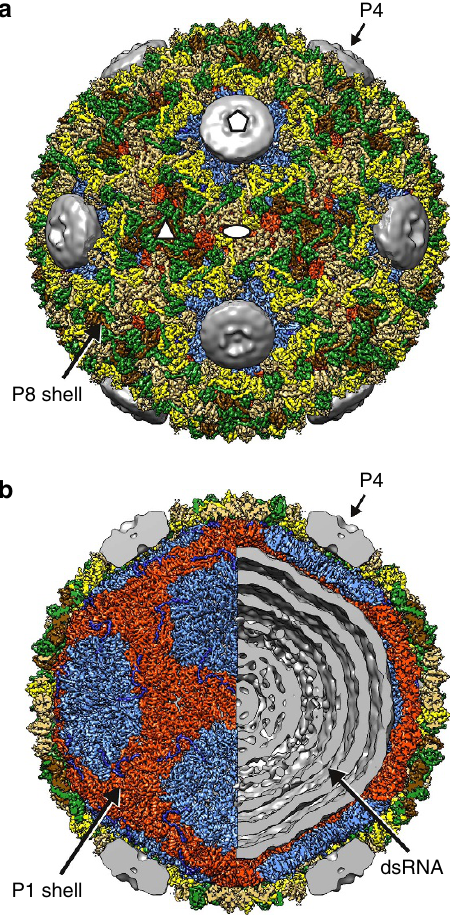
Figure 1 | Cryo-EM structure of bacteriophage / 6 nucleocapsid. ( a , b ) Three-dimensional reconstruction of the NC at 4.0-Å resolution. The P8 trimers forming the outer protein shell are coloured in yellow (P8 Q ), green (P8 R ), gold (P8 S ) and brown (P8 T ). Half of the P8 density was removed to reveal in b the inner protein shell composed of P1 A –P1 B asymmetric dimers, coloured in light blue (P1 A ) and red (P1 B ). The elongated density corresponding to the P4 C-terminus is shown in dark blue. Residual density, not assigned to the aforementioned icosahedrally ordered components was filtered to 15-Å resolution to visualize in a , b the symmetry-mismatched P4 hexamers at the icosahedral five-fold vertices and the dsRNA in b . See also Supplementary Fig.